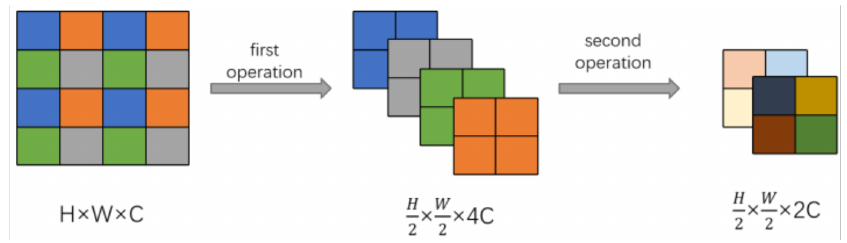
Figure 3. Patch merging.